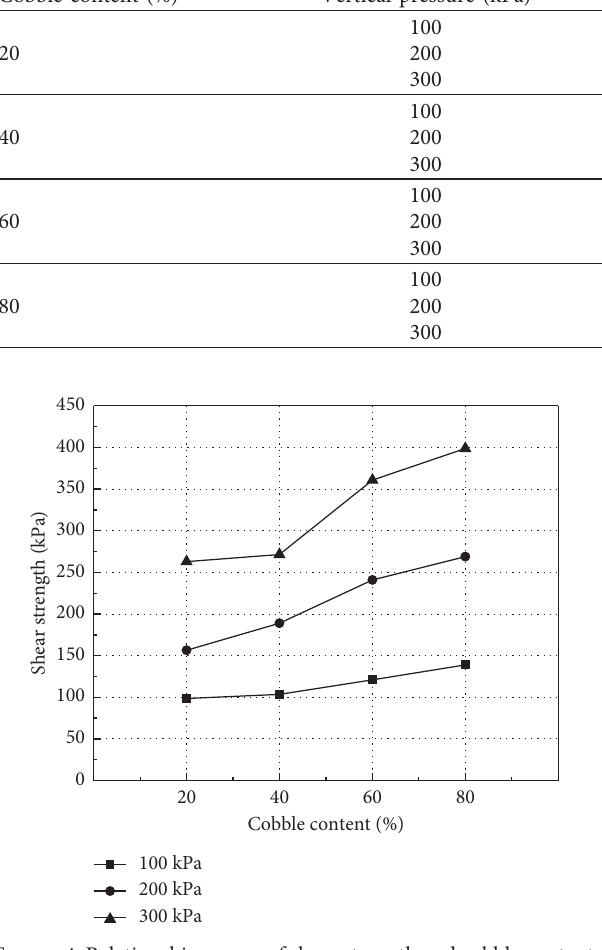
Figure 4: Relationship curves of shear strength and cobble content under different vertical pressure.